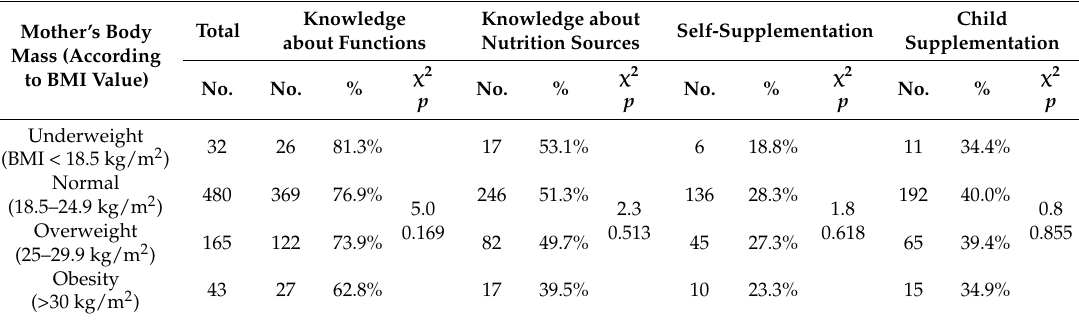
Table 6. The influence of mother’s body mass on knowledge and supplementation of vitamin D ( n = 720) ( p = 0.05).